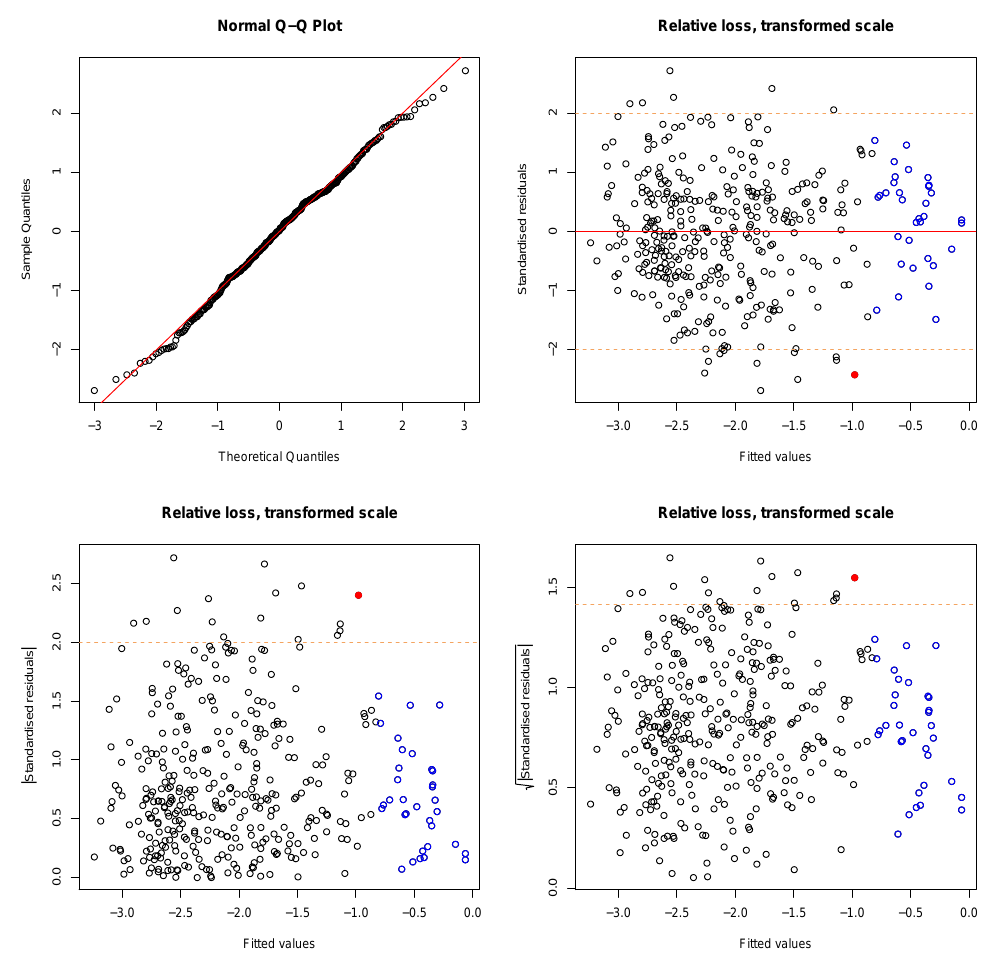
Figure A1. Diagnostic plots for the residuals (transformed degrees of loss) shown by Figure 3a. ( Top left ) Normal-Q-Q-plot, points along diagonal line don’t reject normality (SW: normality with a p -value = 0.385). All other figures show the fitted values on X -axis against the standardised residuals on the Y -axis as normal ( top right ), absolute ( bottom left ) and the square root ( bottom right ) of the absolute values. Blue borders indicate high leverage points, red filled circles indicate high values for Cook’s distance and the orange dashed lines indicate the borders to the definition of large residuals. Heteroscedasticity is not evident. One outlier (Bonferroni outlier test) is not shown in the